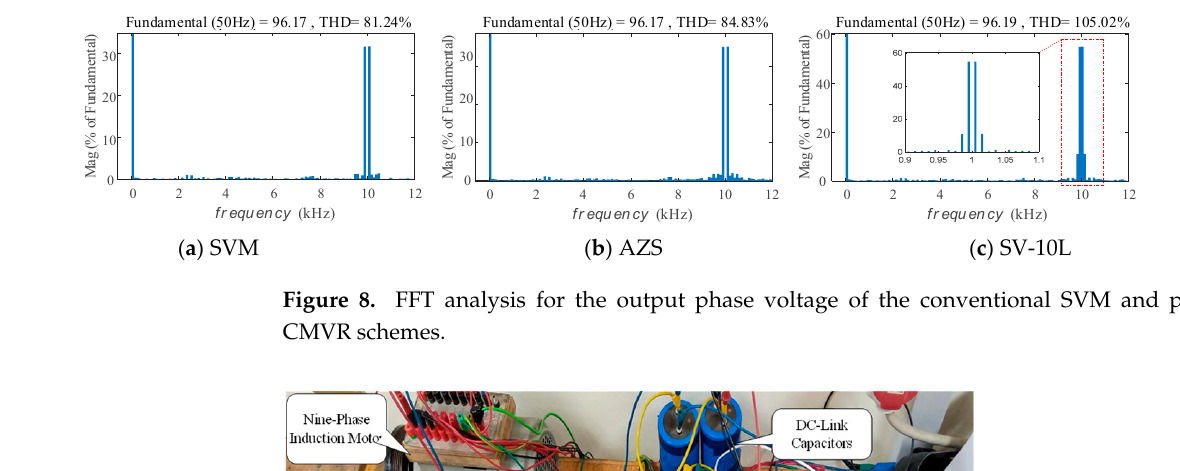
Figure 7. Simulation results for a nine-phase motor based on the conventional SVM and proposed schemes.